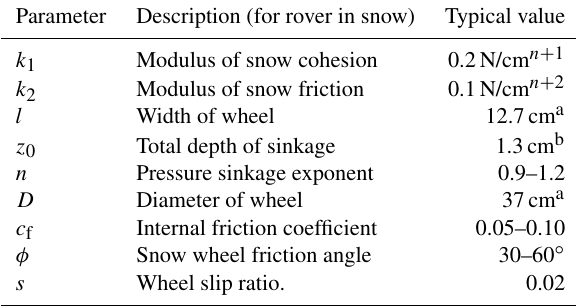
Table 1. Table of parameters used in Bekker locomotion equations (Bekker, 1962), and the values used to parameterize rover resis- tance, traction, and mobility. Snow cohesion parameters ( n , k 1 , k 2 , φ) vary widely depending on the temperature and humidity as snow precipitates, and also depend on the time between snowfall events as the snow settles and metamorphizes reducing the separation be- tween single grains and increasing the bulk density of the medium. The chosen parameters represent dry, low-density polar snow corre- sponding to cold snow ( < 10 ◦ C) after a particularly large snow-fall event. These conditions promote deep sinking and represent a con- servative estimate of the necessary traction for